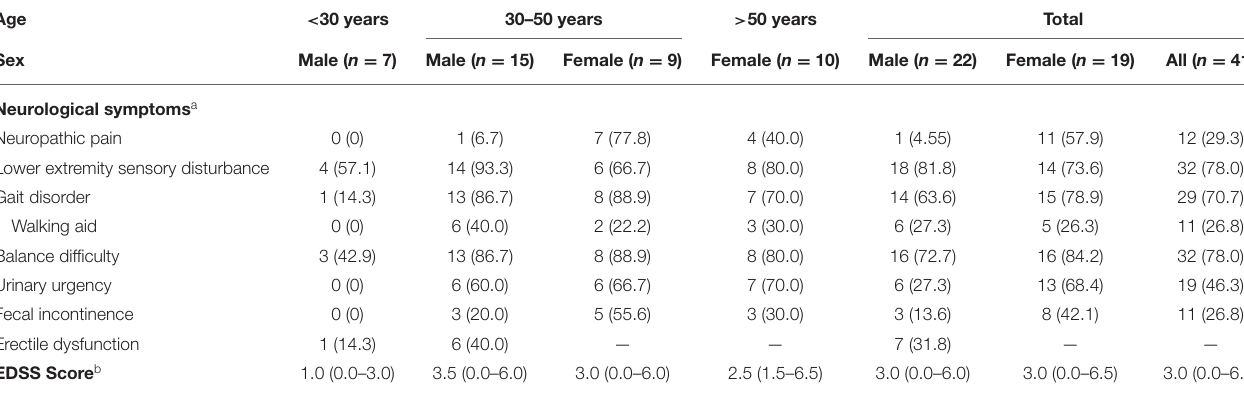
TABLE 1 | Symptoms present on neurological examination and EDSS scores for the patient cohort stratified by age and sex. Age